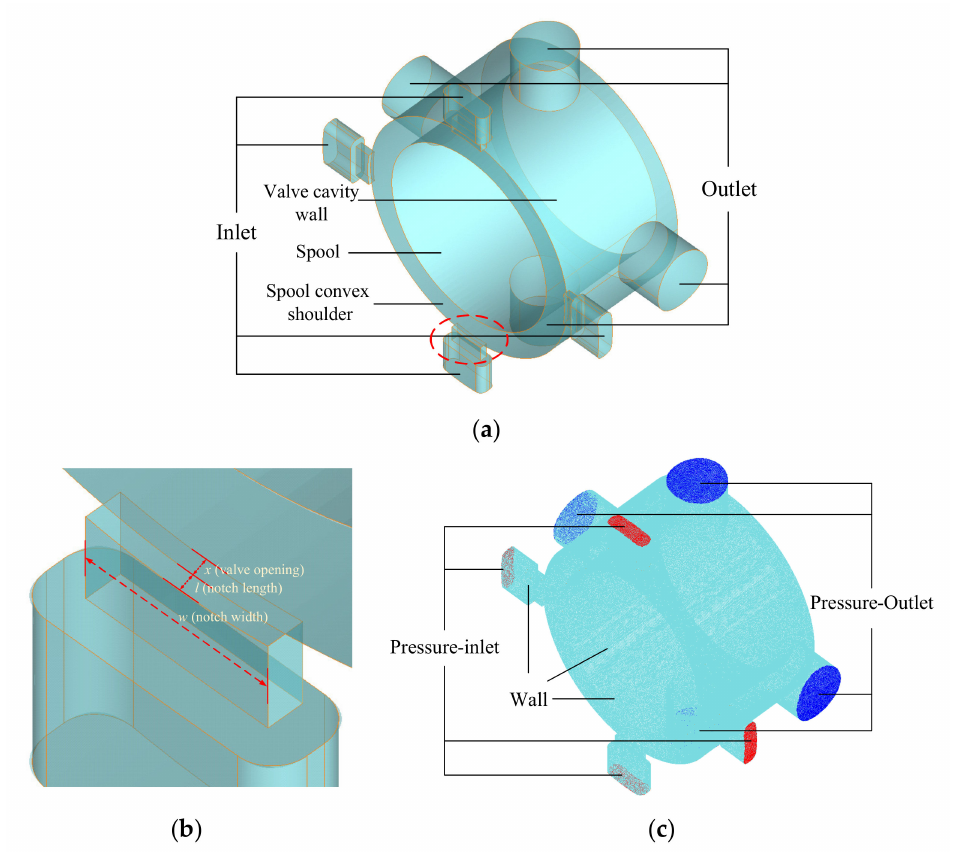
Figure 2. Flow domain for numerical calculation: ( a ) Flow field; ( b ) Geometry near the valve opening; ( c ) Meshing and boundary